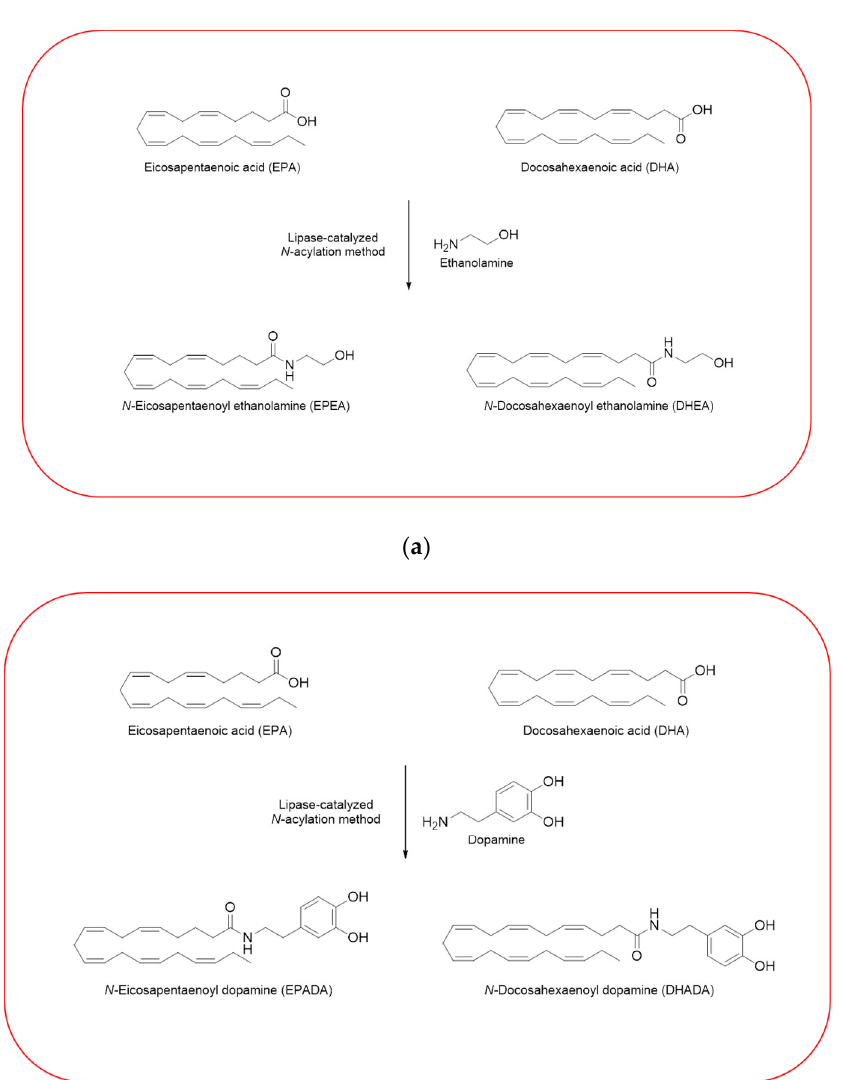
Figure 2. Synthesis of n –3 polyunsaturated fatty acid (PUFA) amides. Chemical structures of two